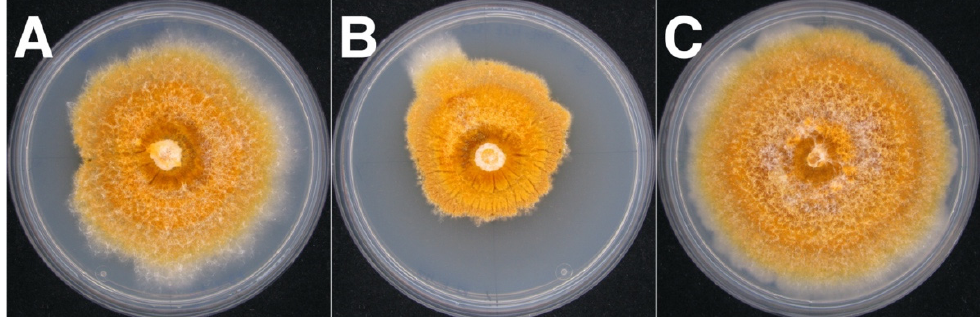
Figure 7. Morphology of isogenic strains of Cryphonectria naterciae after 7 days incubation, shown here by way of example using the recipient strain M10562. ( A ) Infected from the donor M10535 with some sectoring at left side. ( B ) Infected from the donor M10544 showing an extreme sectoring with densely interwoven mycelium. ( C ) Infected from the donor M10545 with regular morphology.